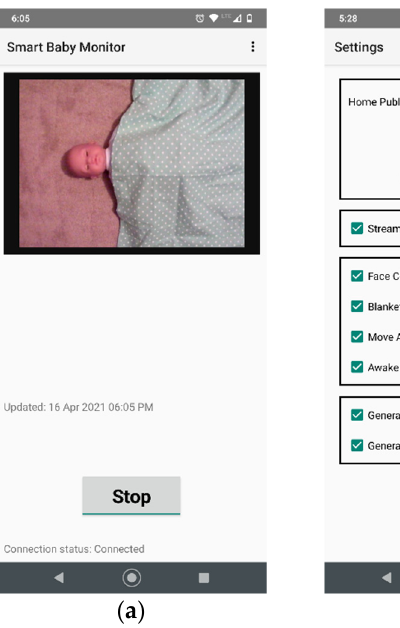
Figure 14. Screenshots of the smartphone app: ( a ) The first screen of the app showing live video stream, last status update date and time, start/stop toggle button, and connection status; ( b ) settings window for configuring the devices public IP and port, video stream, and detection alerts; ( c ) voice and vibration alert generated when the baby’s face is covered; ( d ) alert generated in night light condition when the baby threw off the blanket, frequently moving and eye opened due to awake.